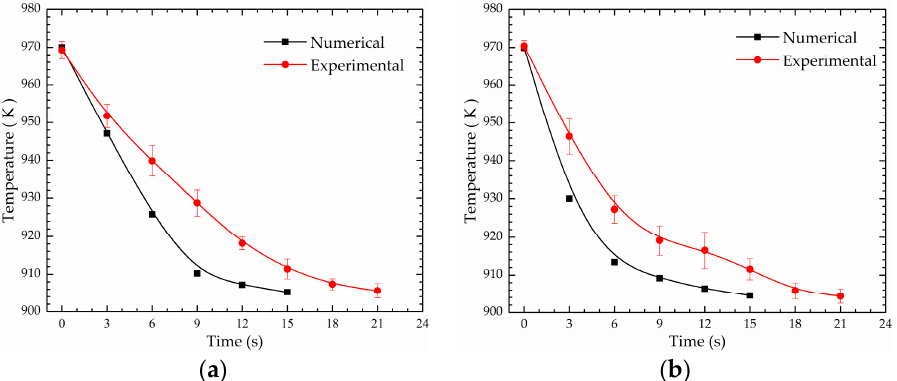
Figure 11. Comparison between simulated and measured time-temperature histories: ( a ) T 1 and ( b ) T 2 .